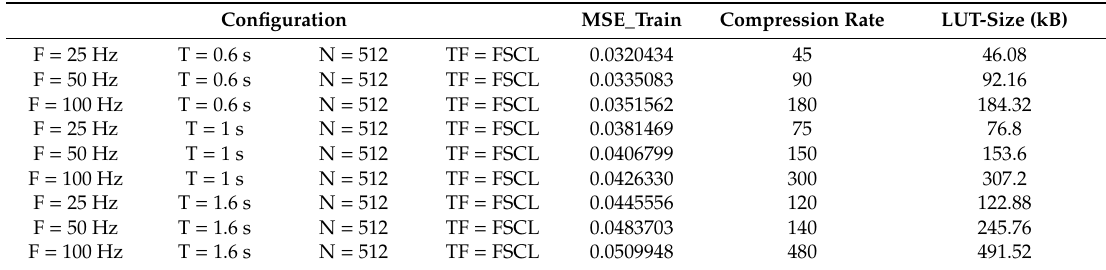
Table 1. Evaluating temporal parameters F and T for the model (TF = FSCL, and N = 512).